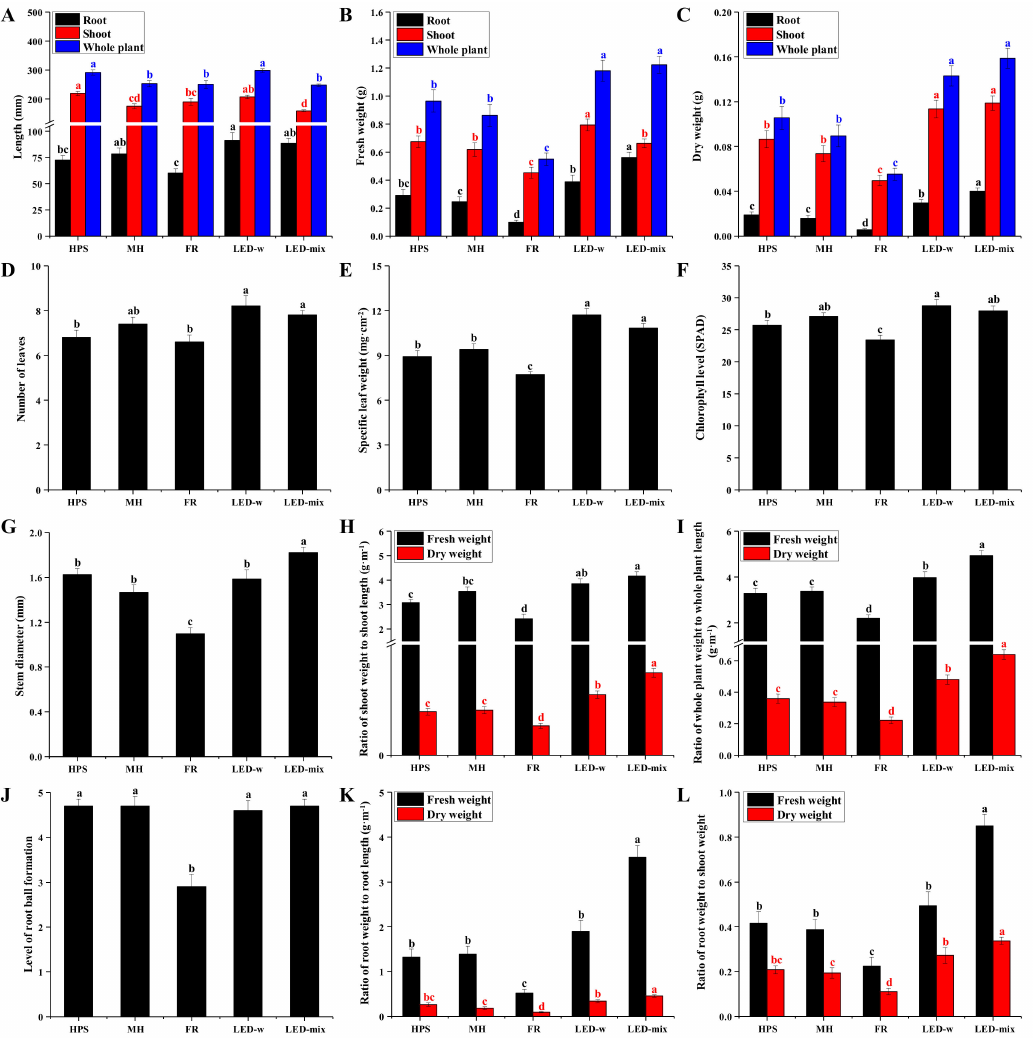
Figure 2. The growth parameters of C. lanceolata seedlings as affected by supplementary light sources: ( A) , Length of root, shoot and whole plant; ( B ), Fresh weights of root, shoot and whole plant; ( C ), Dry weights of root, shoot and whole plant; ( D ), Number of leaves; ( E ), Specific leaf weight; ( F ), Chlorophyll level; ( G ), Stem diameter; ( H ), Ratio of shoot weight to shoot length; ( I ), Ratio of whole plant weight to whole plant length; ( J ), Level of root ball formation; ( K ), Ratio of root weight to root length; and ( L ), Ratio of root weight to shoot weight. Different small letters indicate the significant separation within treatments by Duncan’s multiple range test at a 0.05